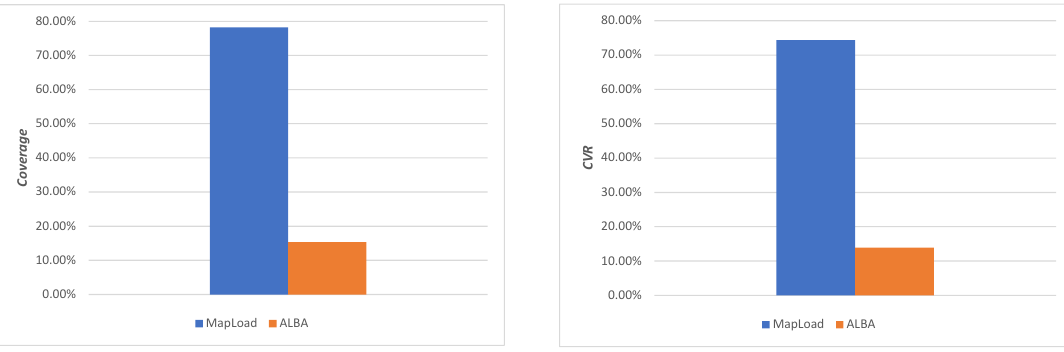
Figure 7. Security metrics comparison of ALBA and MapLoad.